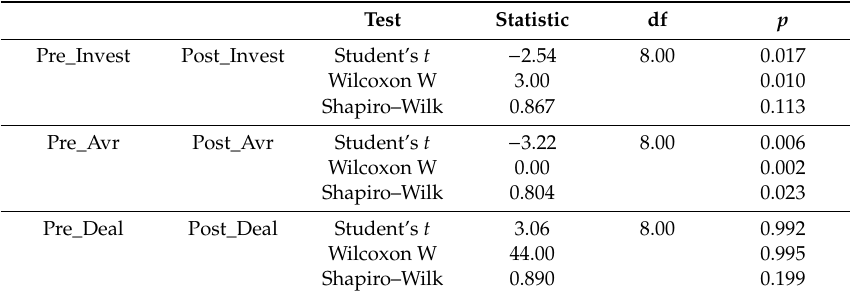
Table 9. The results of the Pre–Post Analysis.